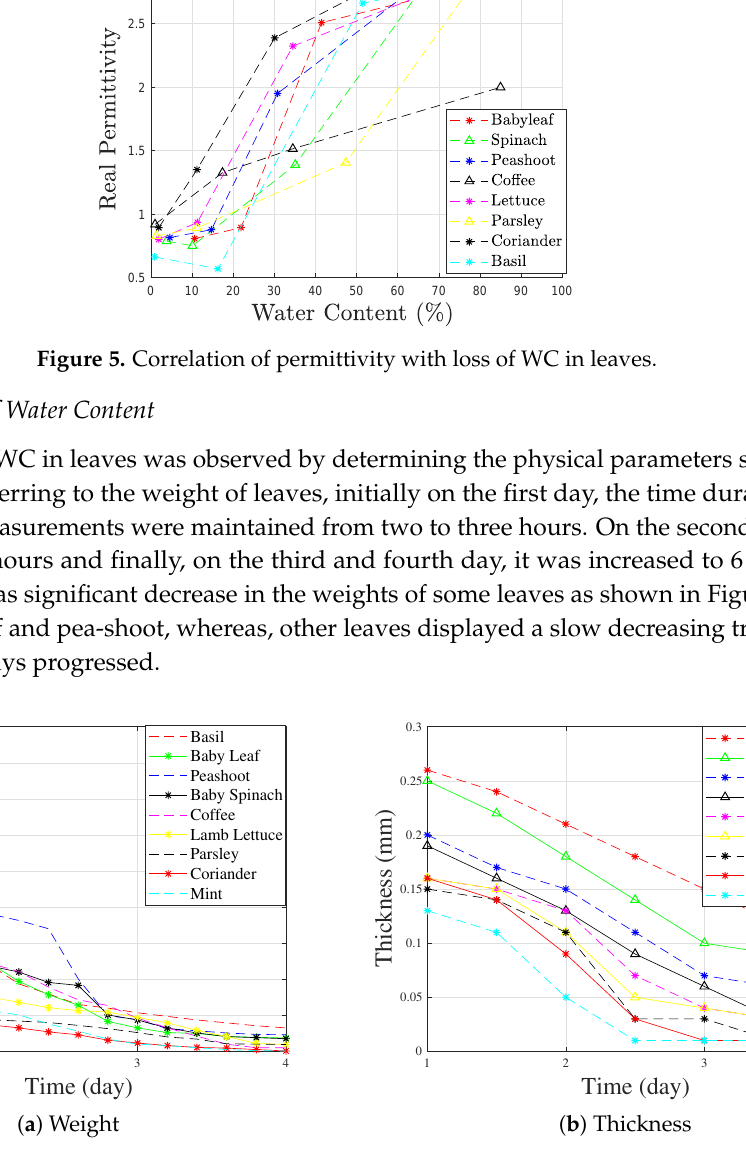
Figure 6. Change in the physical properties of leaves with